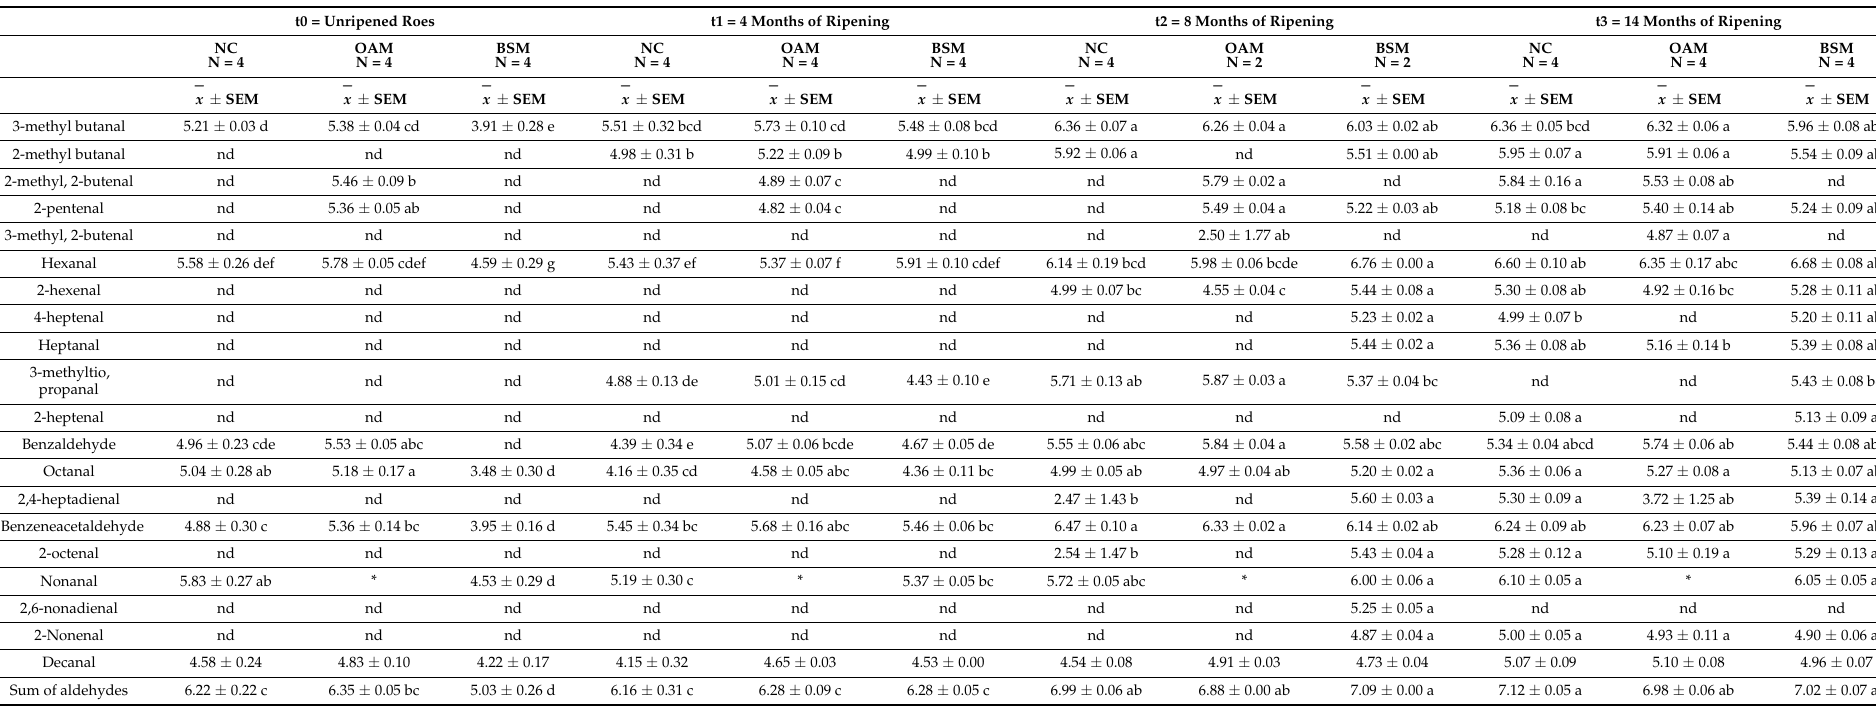
Table 3. Aldehydes detected in caviar during the ripening time for each treatment. Chromatographic areas are expressed in Log10. Data are presented as mean ( x ) ± standard error of the mean (SEM). Legend: NC, sodium chloride (NaCl); OAM, organic acid mixture; BSM: borax and salt